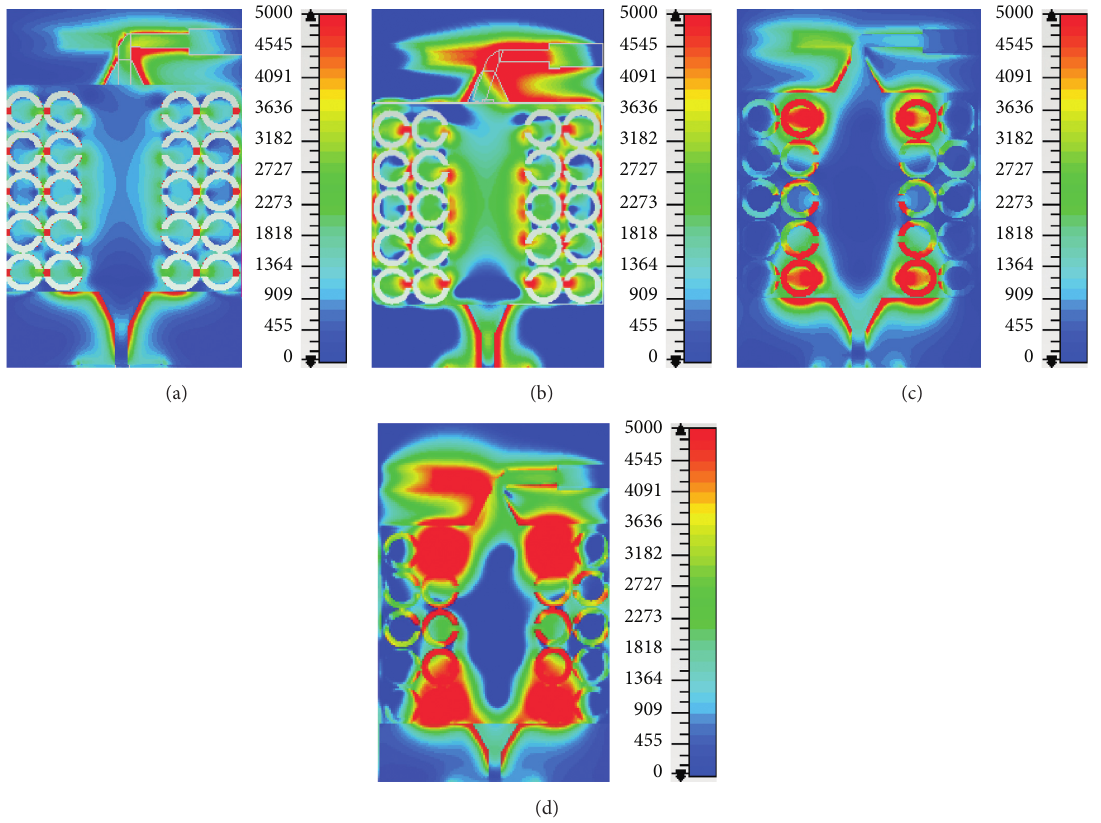
Figure 7: The E-field distribution over the antenna: (a) θ � 0 ° at 2.4 GHz, (b) θ � 20 ° at 2.4GHz, (c) θ � 0 ° at 5.5GHz, and (d) θ � 20 ° at 5.5GHz.